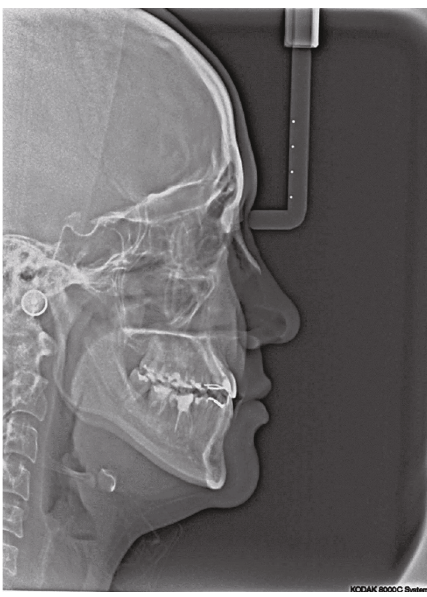
Figure 7: Posttreatment cephalometric